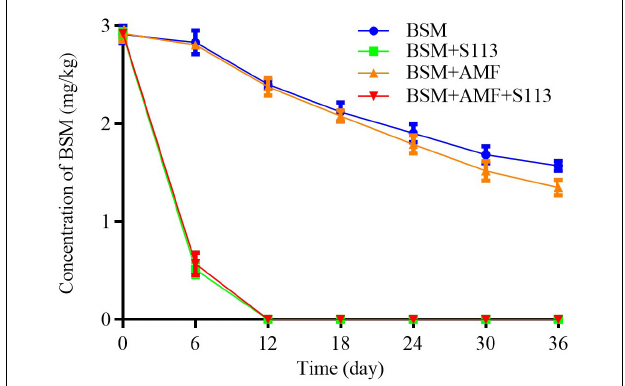
FIGURE 4 | The residual concentration of Bensulfuron-methyl (BSM) in Rhizosphere soil.